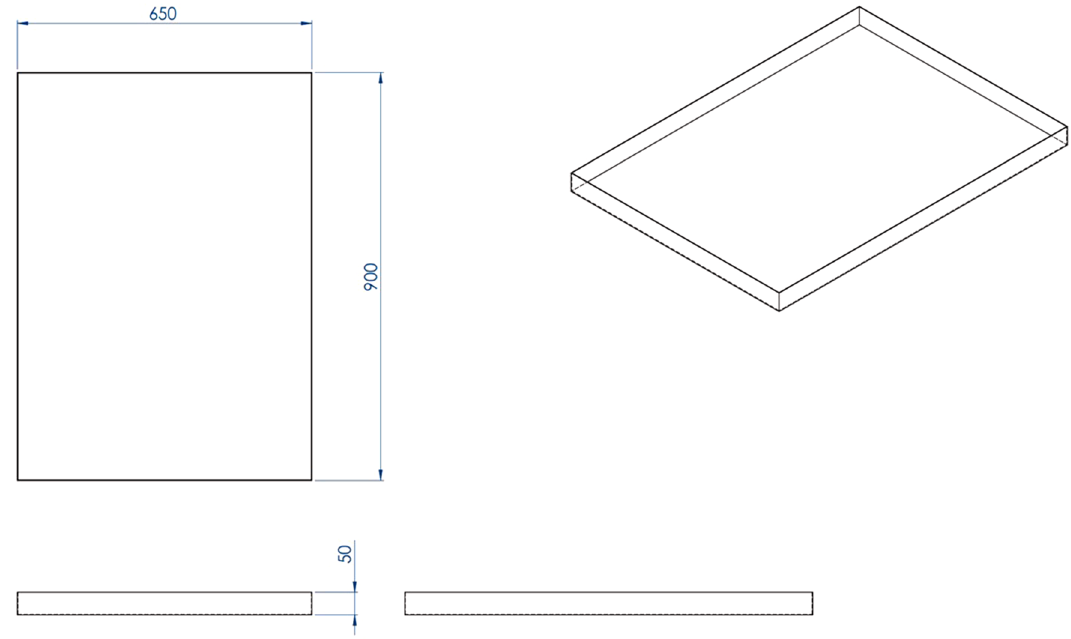
Fig. 5 Dimensions of the water tray